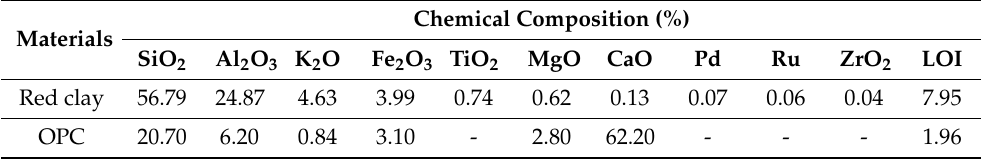
Figure 4. Red clay. Table 1. Chemical compositions of Table 1. Chemical compositions of materials.